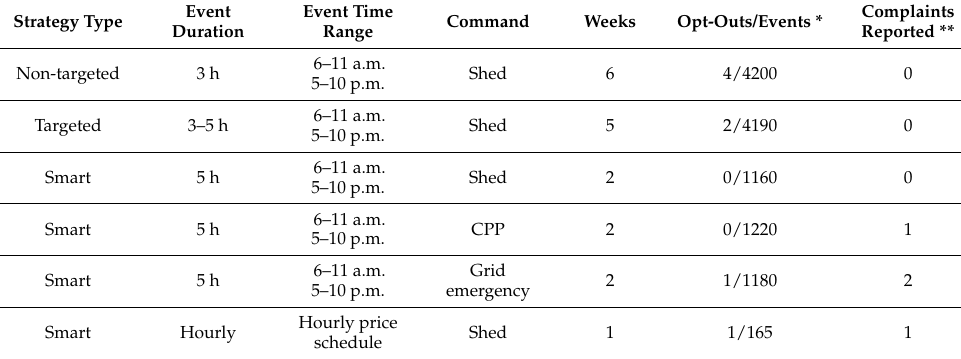
Table 5. Consumer Satisfaction